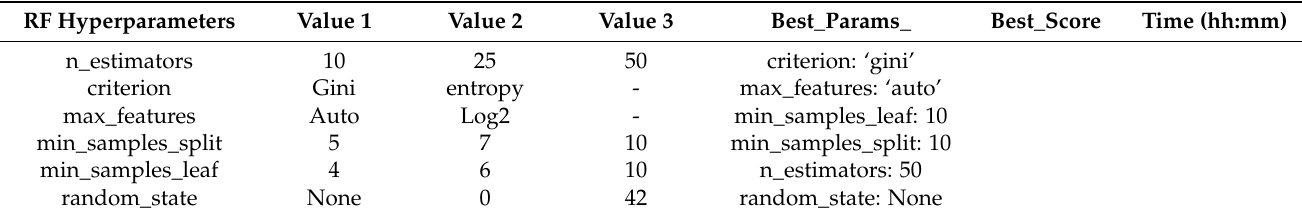
Table 3. GridSearchCV proceeding for RF best parameter’s